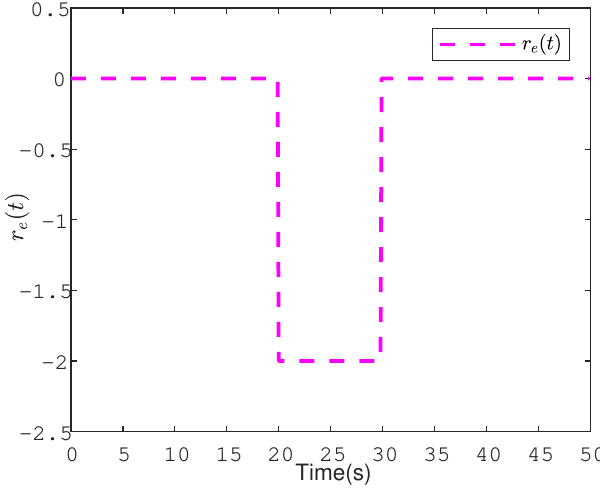
Figure 4. The trajectories of r e ( t ) with fault.